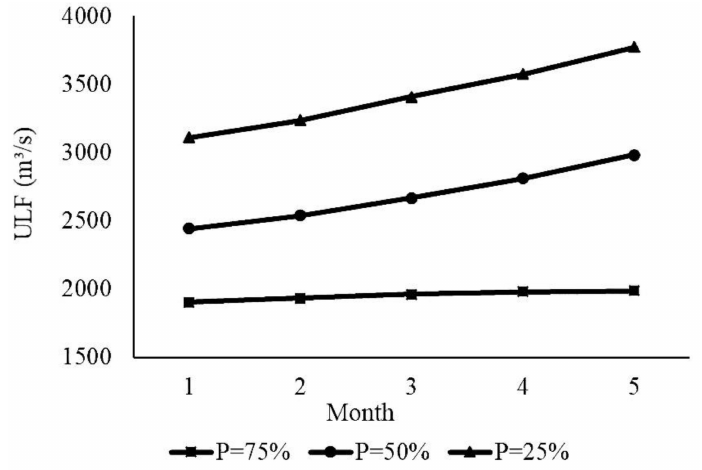
Figure 5. The ULFs in typical years of wet, normal and dry